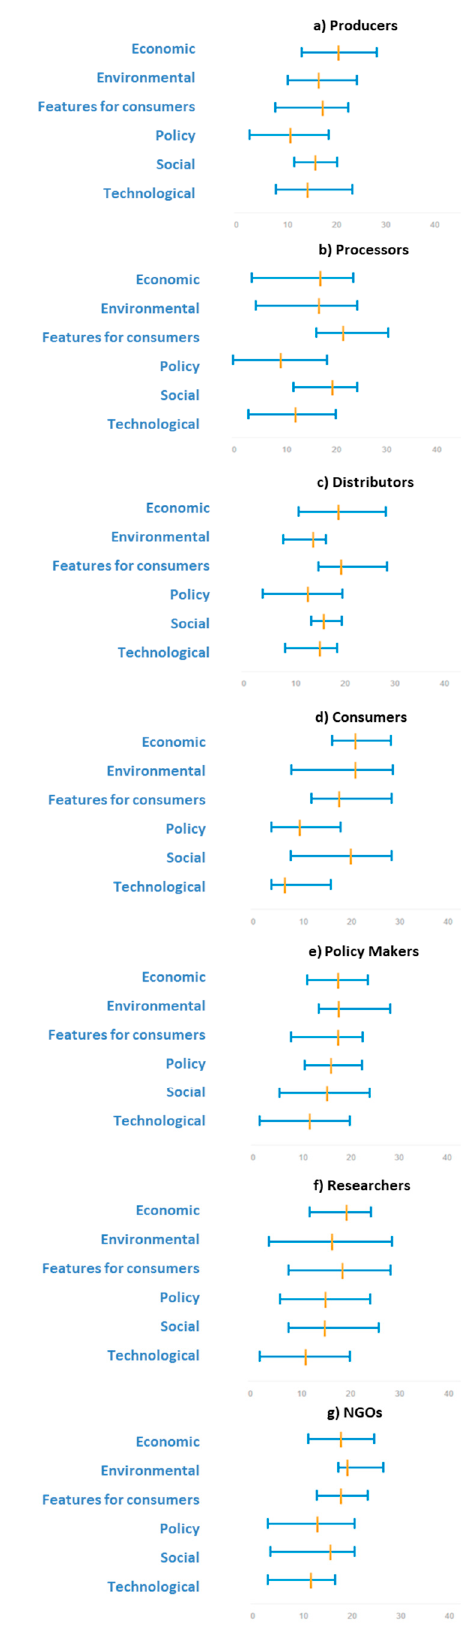
Figure A3. Weights (%) assigned to each criterion by stakeholder group: ( a ) Producers; ( b ) Processors; ( c ) Distributors; ( d ) Consumers; ( e ) Policymakers; ( f ) Researchers; and ( g ) NGOs.